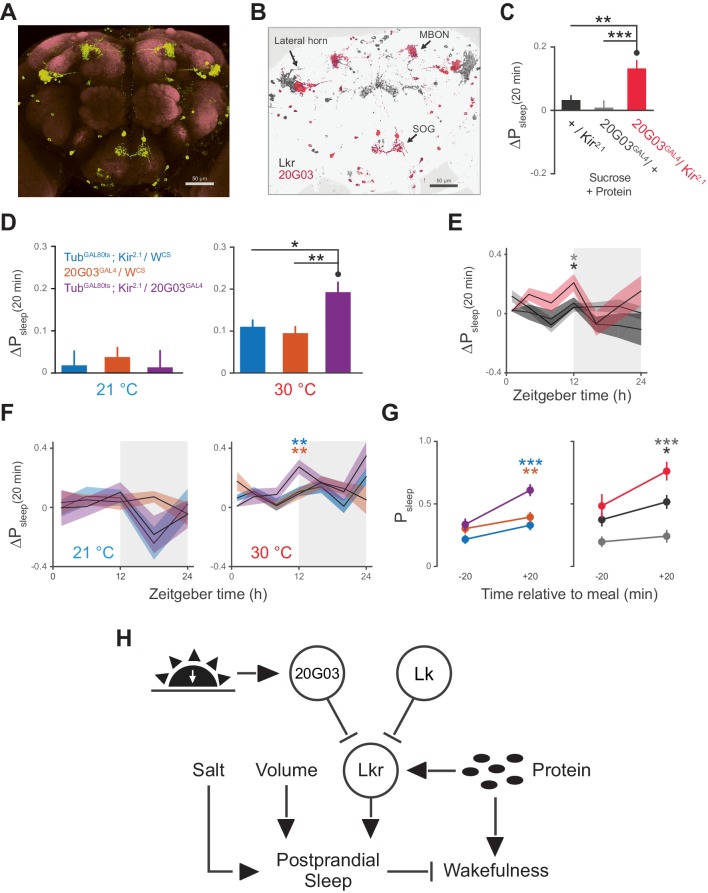
20G03 neurons inhibit postprandial sleep in a circadian manner.(A) 20G03GAL4 drives mCD8-GFP expression in neurons with cell bodies positioned proximal to cell arborizations of those labeled by LkrGAL4. (B) Overlaid images of 20G03GAL4 and LkrGAL4 expression show close proximity between cell types in the lateral horn and SOG. (C) Overexpression of Kir2.1 channel in 20G03GAL4-labeled cells results in an enhanced postprandial sleep response (30 flies per genotype, n = 805 meals, Kir2.1/ w1118; 488, 20G03GAL4 / w1118; 285, Kir2.1/ 20G03GAL4; **p<0.01; ***p<0.001, Kruskal-Wallis test followed by Dunn’s multiple comparisons). (D) Conditional silencing of 20G03GAL4-labeled cells in adulthood is sufficient to increase postprandial sleep (24 flies per genotype, n = 493 meals, TubGAL80ts; Kir2.1/ wCS; 575, 20G03GAL4 / wCS; 528, TubGAL80ts; Kir2.1/20G03GAL41; *p<0.05; **p<0.01, Kruskal-Wallis test followed by Dunn’s multiple comparisons). (E) Time-course of postprandial sleep reveals that effect of 20G03GAL4 silencing is most prominent from ZT 10–14 (time-course partitioned into 4 hr bins, shaded region indicates dark period; *p<0.05, Kruskal-Wallis test followed by Dunn’s multiple comparisons). (F) Conditional silencing effects are also stronger at dusk ZT 10–14 (**p<0.01, Kruskal-Wallis test followed by Dunn’s multiple comparisons). (G) Comparison of Psleep in the 20 min before and after each meal for both 20G03GAL4 manipulations (color codes from C and D; *p<0.05; **p<0.01, ***p<0.001, Kruskal-Wallis test followed by Dunn’s multiple comparisons). (H) Proposed model for regulation of postprandial sleep by dietary components and neuronal circuitry. Meal volume, ingested salt, and protein drive postprandial sleep. Sleep induced by ingested protein acts through Lkr neurons. Protein also induces a waking response independent of Lkr neuronal activity. Leucokininergic (Lk) or non-leucokininergic (20G03) cell populations can independently inhibit postprandial sleep, possibly through modulation of Lkr neuronal activity.